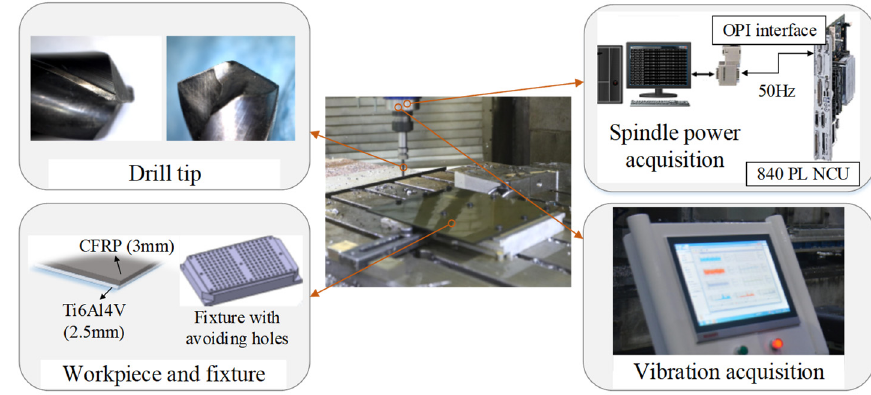
Figure 7. Experimental set-up. Table 1. Geometric parameters of drill bit.